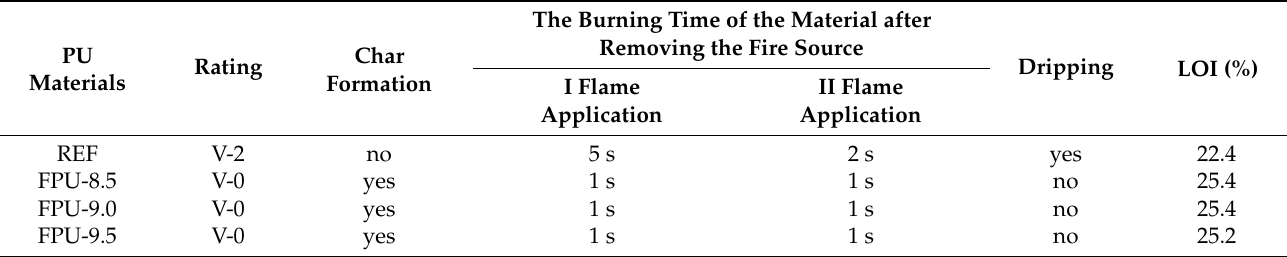
Table 6. UL-94 and LOI tests